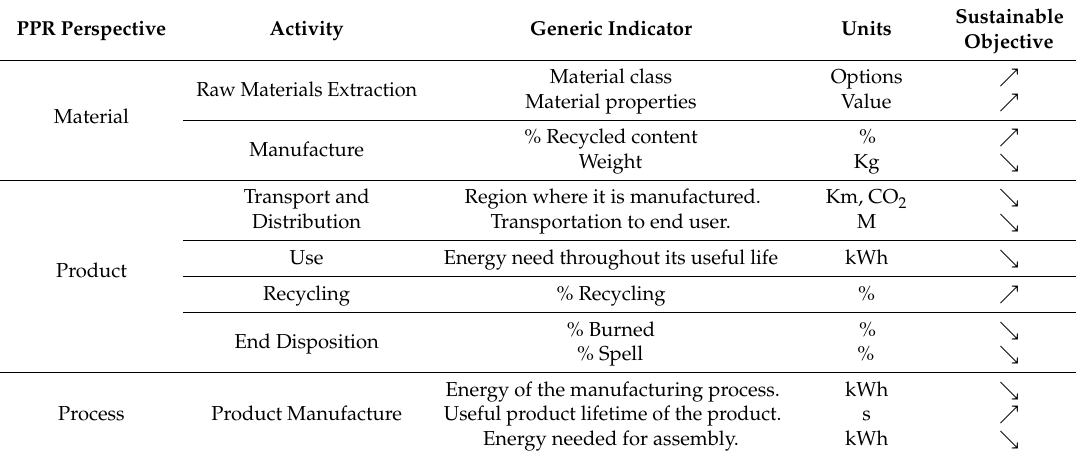
Table 1. Product, material, and resources activities as general performance